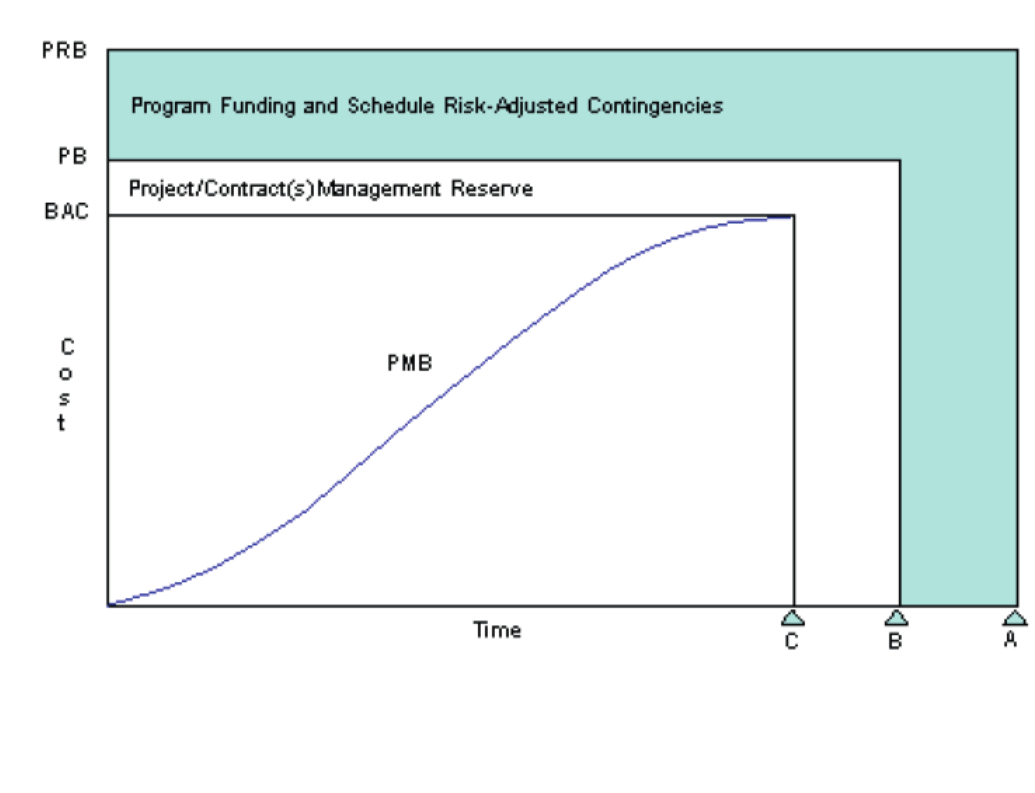
Fig. 13. Performance Measurement Baseline (PMI, 2011: